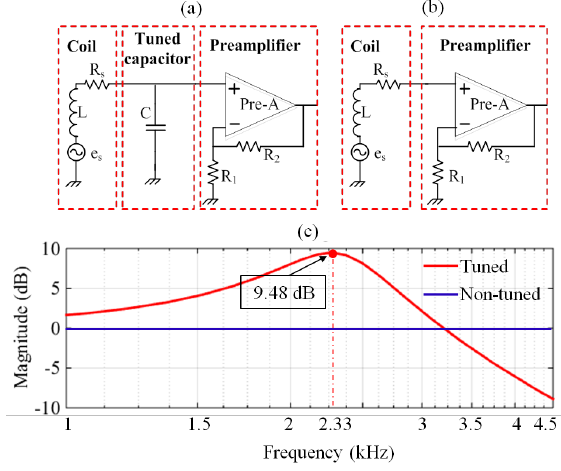
Figure 1. Schematics of the coil sensors with tuned and non-tuned configurations. ( a ) The tuned design; ( b ) The non-tuned design; ( c ) The amplitude-frequency characteristic curves of tuned and non-tuned configurations.